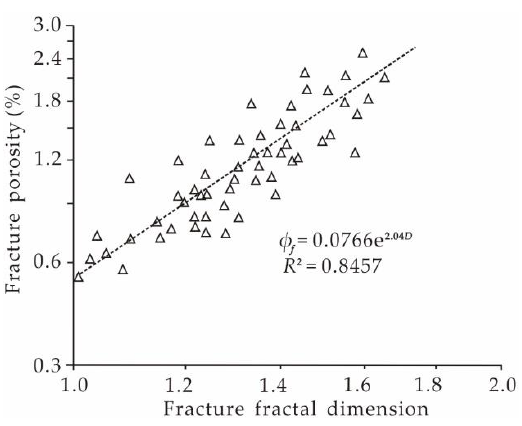
Figure 10. Relationship between fractal dimension and fracture porosity.